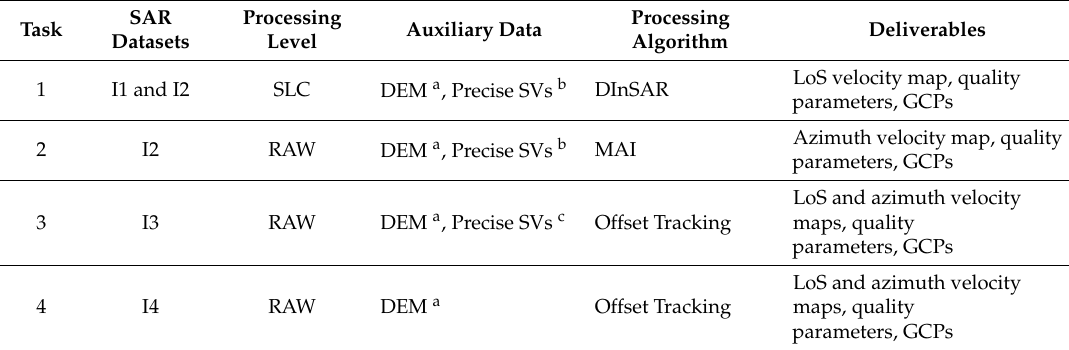
Table 2. Participant tasks and